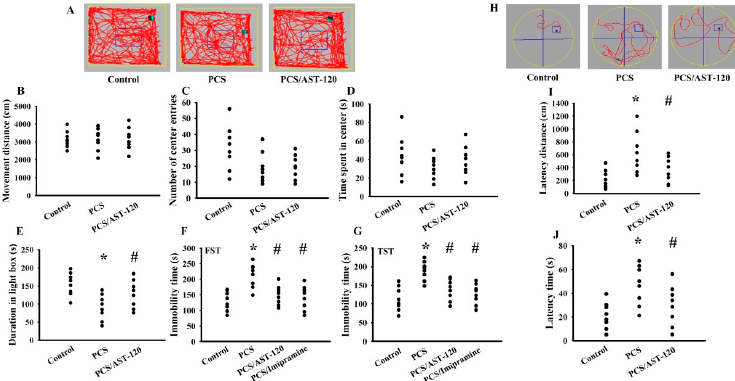
Figure 4. PCS caused behavioral alterations. Unilateral nephrectomized mice were intraperitoneally injected with PCS (0, Control; and 100 mg/kg, PCS) and the PCS-injected mice were orally given with AST-120 (400 mg/kg, PCS/AST-120) for 7 weeks. The tracking paths ( A ), distance in movement of spontaneous locomotor activity ( B ), numbers of central zone entries ( C ), and the time spent in the central zone ( D ) was evaluated by the open field test. The duration of light preference was evaluated by the light/dark box test ( E ). An FST was conducted and the duration of immobility was recorded ( F ). A TST was performed and the duration of immobility was recorded ( G ). Antidepressant imipramine (20 mg/kg) was intraperitoneally administrated 1 h prior to the FST ( F ) and TST ( G ). After training for consecutive 3 days, the tracking paths ( H ), distance ( I ), and time ( J ) required to reach the hidden platform were recorded for the Morris water maze test. * p < 0.05 vs. control group and # p < 0.05 vs. PCS group, n = 8.